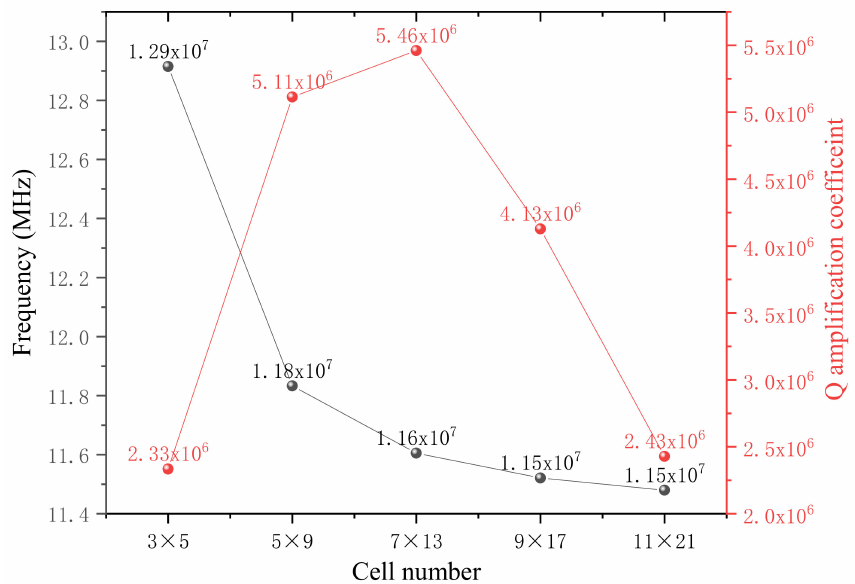
Figure 10. The correlation between cell number and Q amplification coefficient as well as the resonant frequency. The largest Q amplification coefficient does not belong to the largest structure, instead originating from the moderate one consisting of the 7 × 13